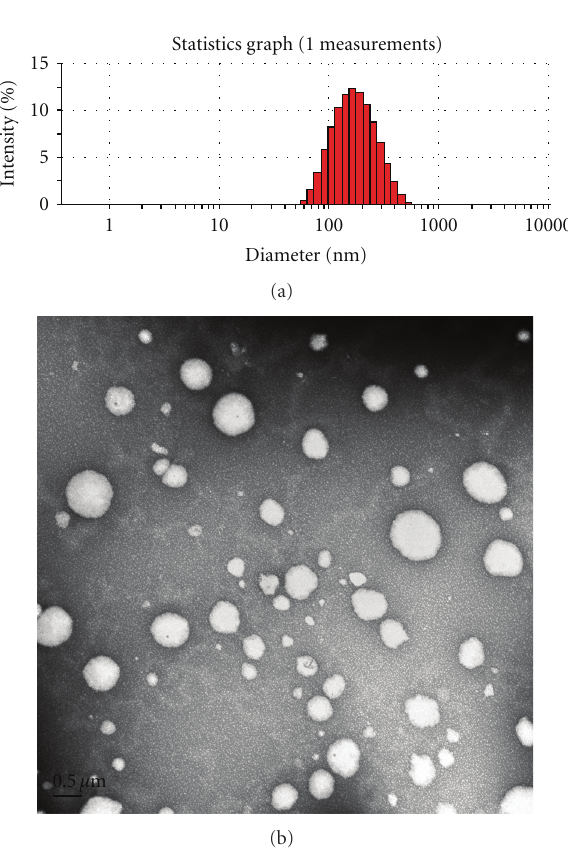
Figure 1: Typical particle size and distribution of the PTX microemulsion (a). Transmission electron micrograph of PTX microemulsion ((b), Bar = 0.5 μ